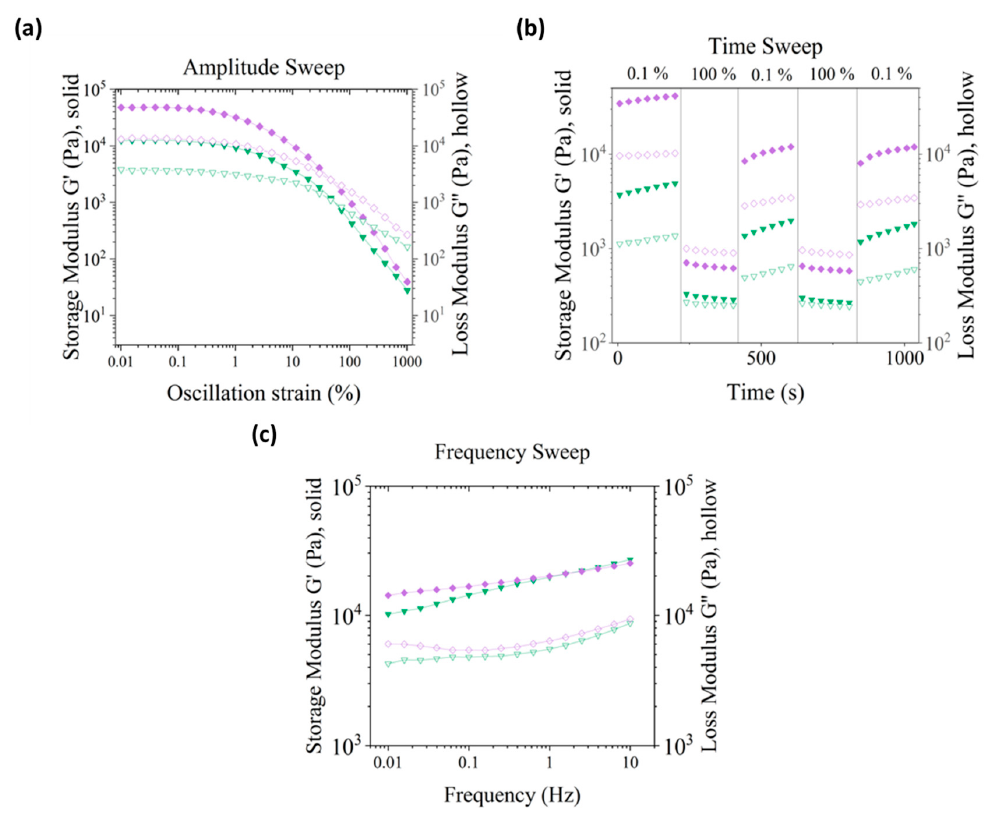
Figure 4. ( a ) The strain sweeps, ( b ) dynamic strain tests alternating 0.1% and 100% strain at short times, and ( c ) frequency sweeps for the inks: Alg_MCC 40 ( ▼ ) and Alg_MCC 40 _FFY ( ♦ ).